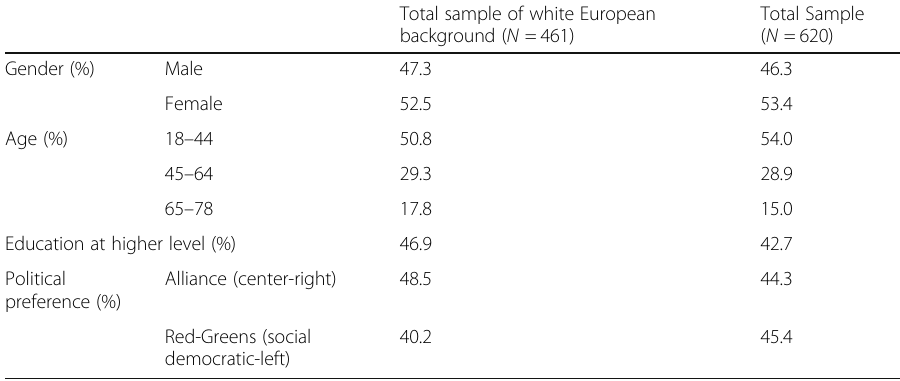
Table 2 Comparison of background characteristics of the white European respondents analyzed in logistic